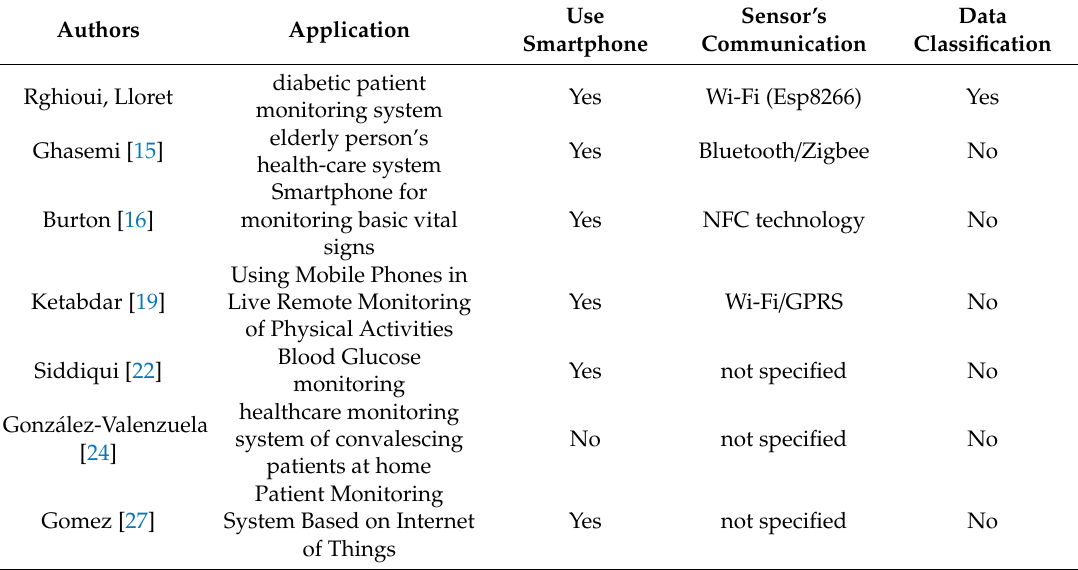
Table 1. Comparisons of the proposed application and other state-of-the-art